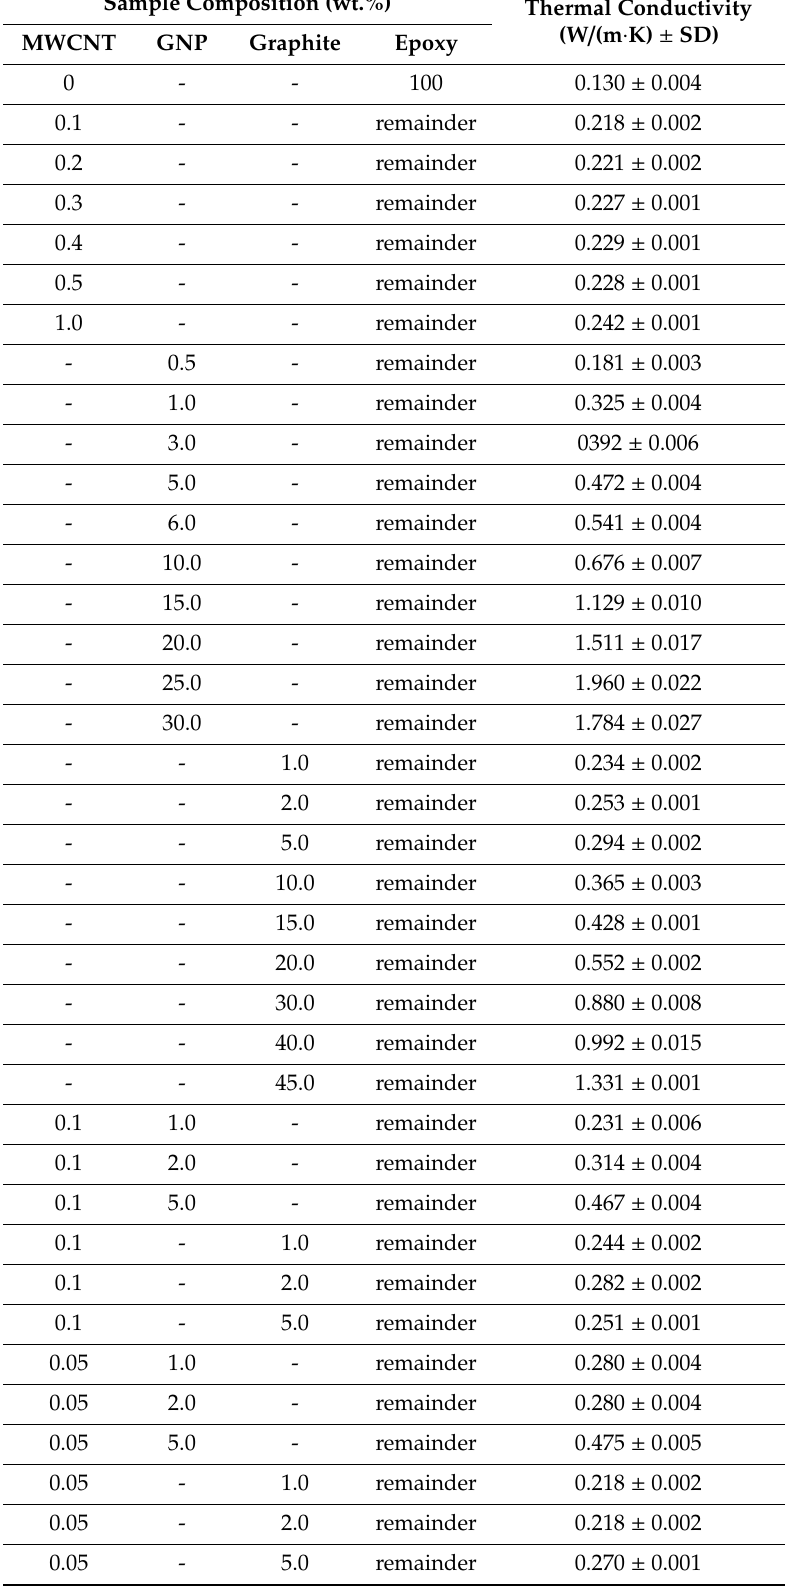
Table 4. Thermal conductivity of the two-components and the hybrid (three-components) epoxy-based